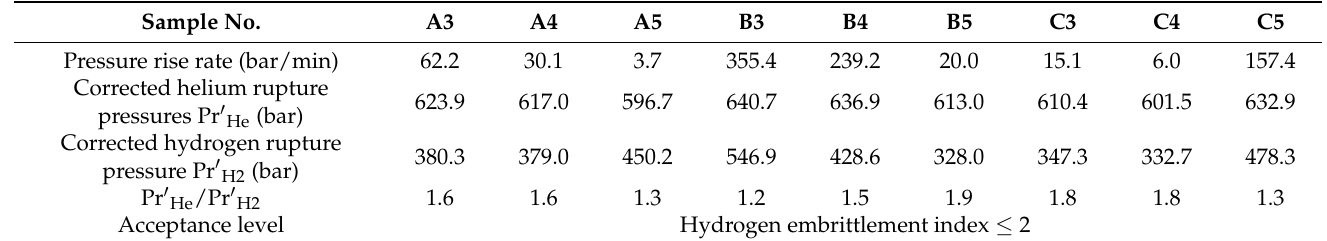
Table 4. Ratio Pr (cid:48) He /Pr (cid:48) H2 for different